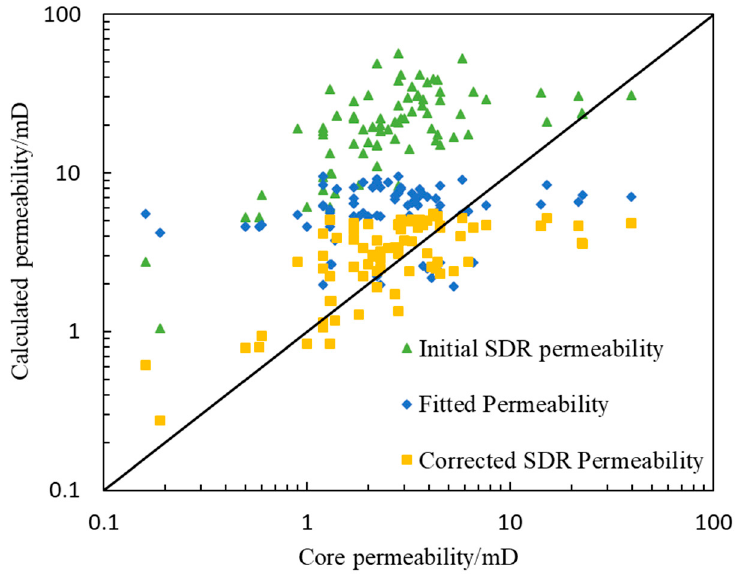
Figure 9. Comparison of permeability calculated by various methods and core analysis results.